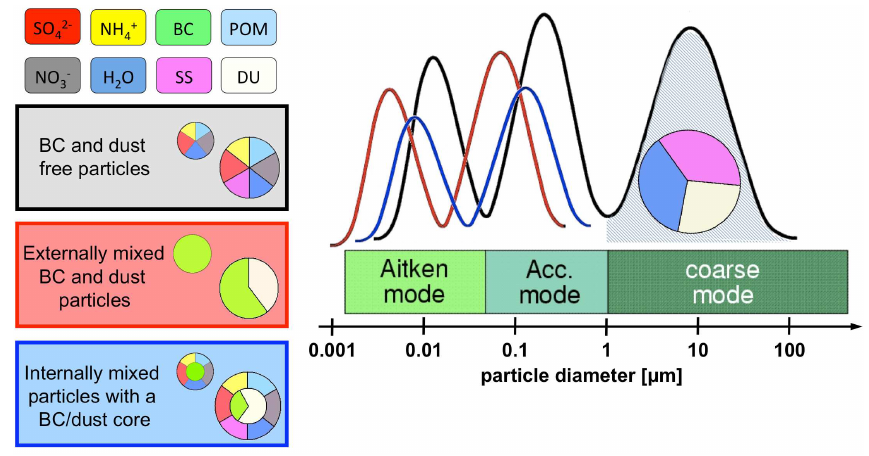
Fig. 1. Schematic representation of the aerosol distribution in MADE-in. BC indicates black carbon, POM particulate organic matter, SS sea salt and DU dust. The shaded mode is the coarse mode, which does not interact with the sub-micrometer modes. The black line depicts the fine modes without BC and dust, the red line the modes for externally mixed BC and dust particles and the blue line the modes for internally mixed BC and